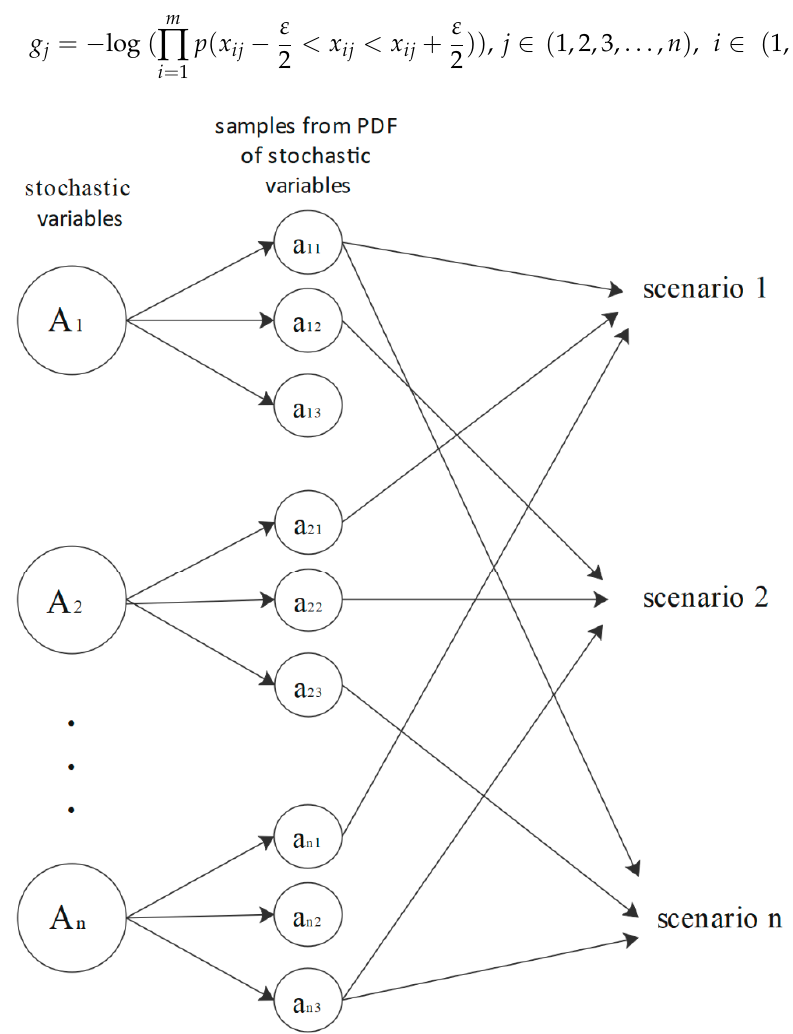
Figure 1. Scenario generation by mixing deterministic values obtained from PDF of stochastic pa- rameters.